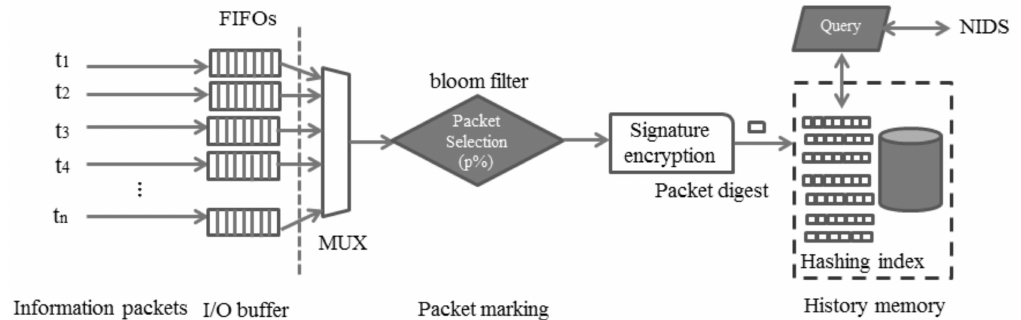
Figure 5. Packet marking mechanism with a Bloom filter and an auditing function in the Source Path Isolation Engine (SPIE)